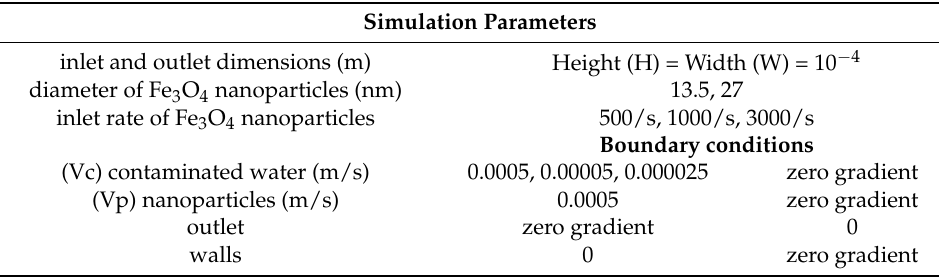
Table 3. Parameters during the